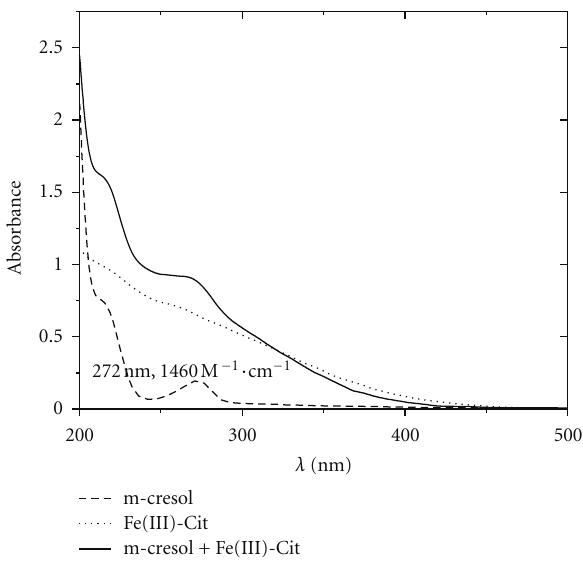
Figure 6: Comparing of the UV-Vis absorption spectra of m-cresol 0.1mM, Fe(III)-Cit 0.3 mM and mixture of m-cresol/Fe(III)-Cit (0.1mM, 0.3mM).